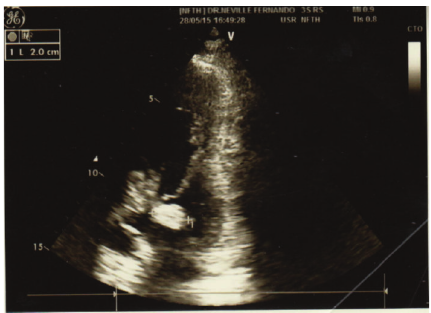
Figure 2: Colonoscopy image of the ascending colon at the level of hepatic flexure showing the tumour.